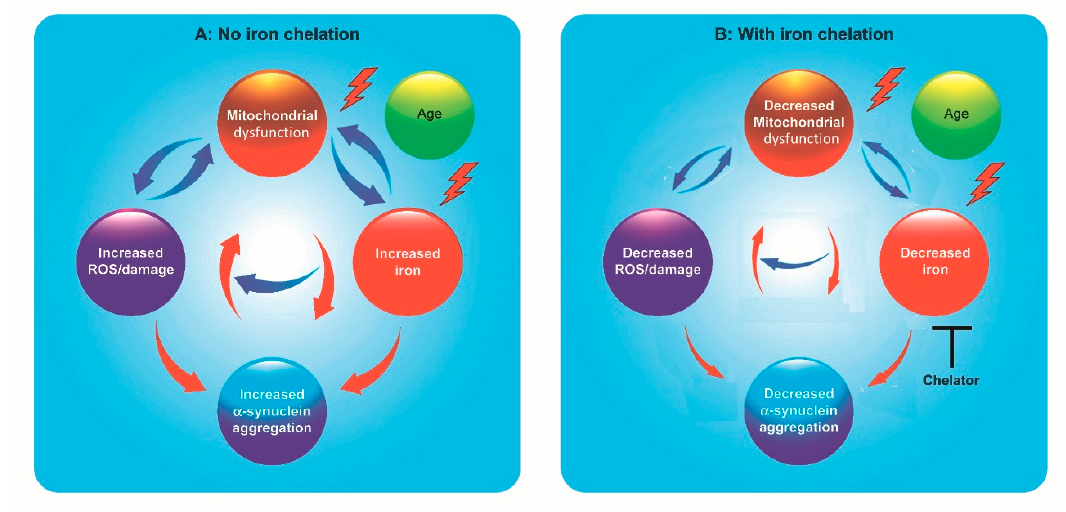
Figure 1. Self-feeding cycles in Parkinson’s neurodegeneration. ( A ) Blue arrows: Mitochondrial dysfunction, caused by internal or external toxins, or derived from genetic factors, results in increased oxidative stress and in decreased synthesis of iron–sulfur clusters, which in turn results in the spurious activation of iron regulatory protein IRP1 and increased iron uptake. Both increased ROS and increased iron produce additional mitochondrial dysfunction through the generation of the hydroxyl radical. Red arrows: Increased ROS and increased iron levels induce α -synuclein aggregation, establishing a positive feedback cycle including mitochondrial dysfunction, further taxing energy production. ( B ) Iron chelation decreases redox-active iron and the production of damaging ROS. The decrease in ROS and redox-active iron results in decreased α -synuclein aggregation. The decrease in ROS and α -synuclein aggregation also results in improved mitochondrial function. Thus, decreasing redox-active iron by chelation slows or stops the process of neuronal death. In this scheme, age is a neurodegeneration factor not influenced by iron chelation.